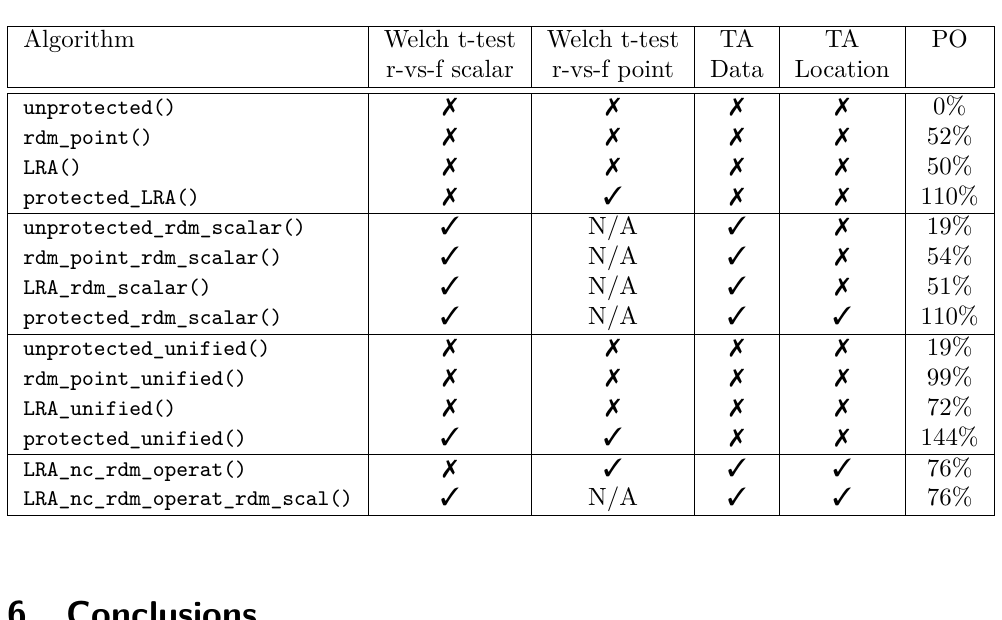
Table 1: Collective Evaluation